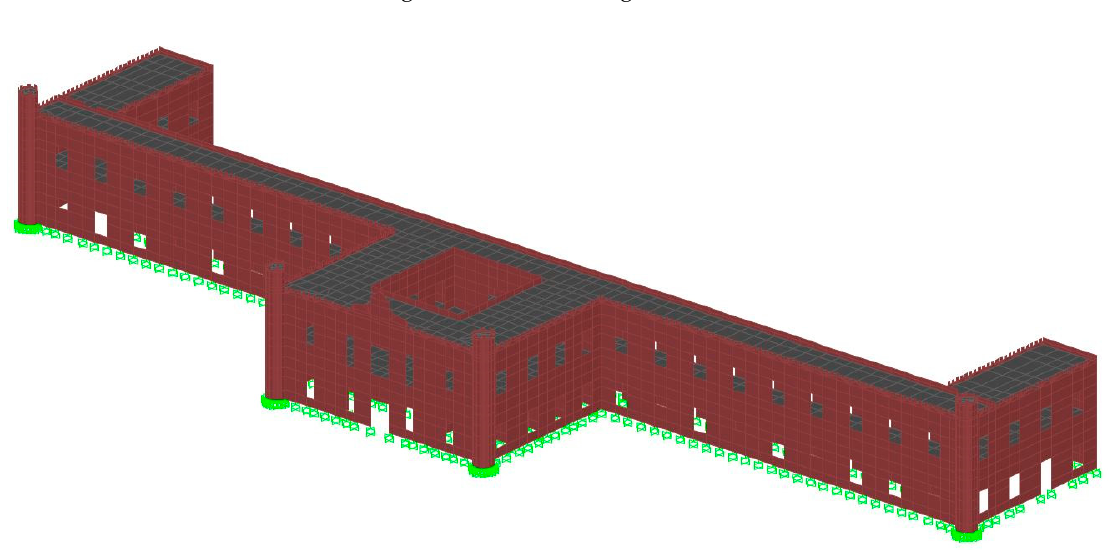
Figure 7. AGN Government Building floor-use [12].